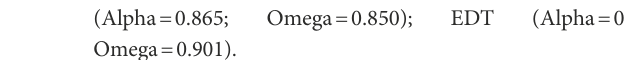
TABLE 21 Correlation between the types of internal and external regulation in Technology Psychology ( n =